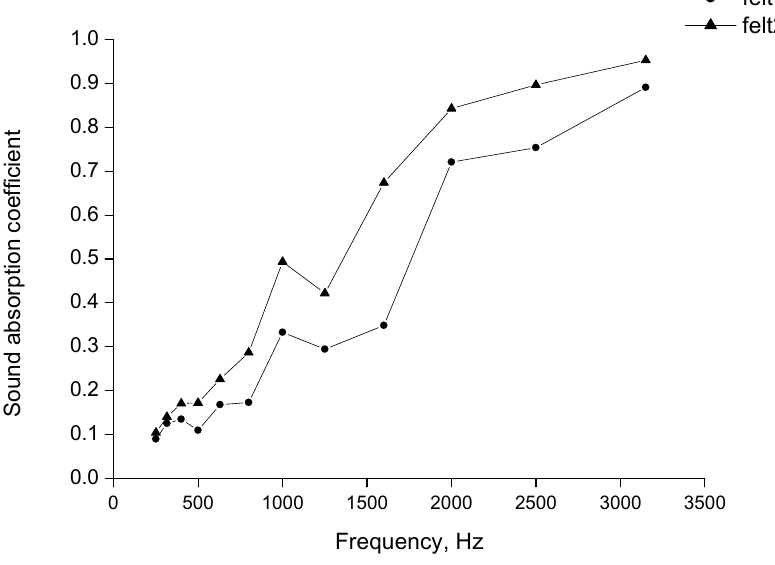
Figure 7. Sound absorption coefficient in normal incident for wool